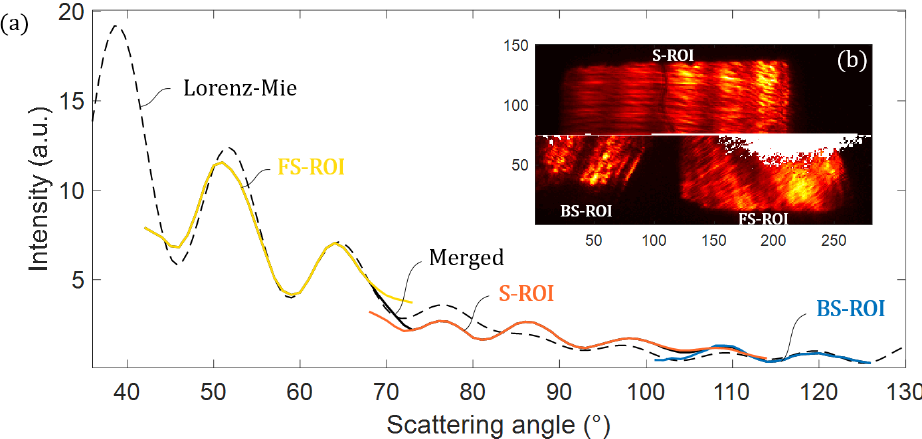
Figure 16. ( a ) Reconstructed signature from experimental image plotted with the theoretical signature. ( b ) Experimental image of a 3 μ m PSL used for the reconstruction.